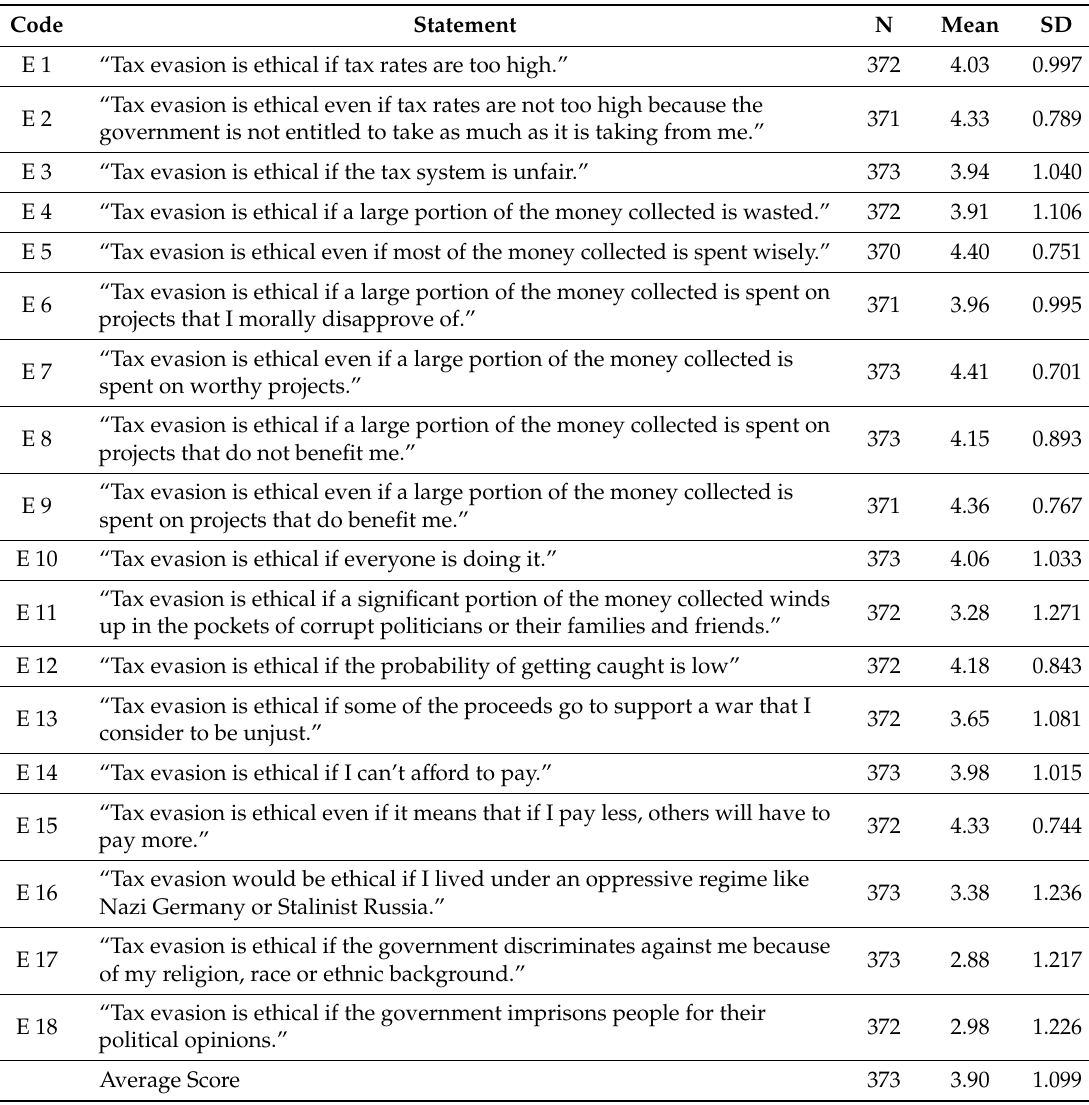
Table 3. Ethics of tax evasion—18